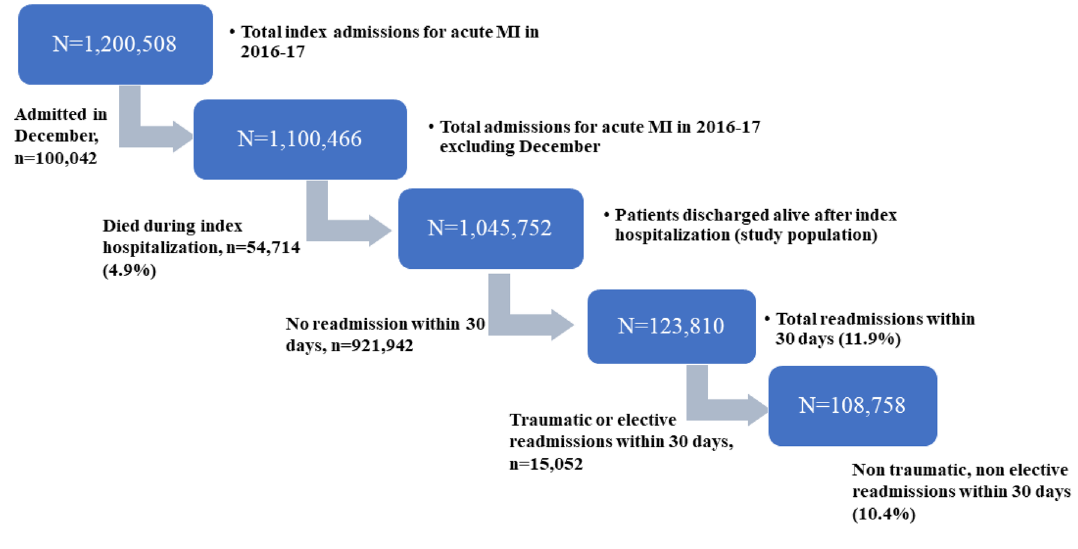
Figure 1. Study flow